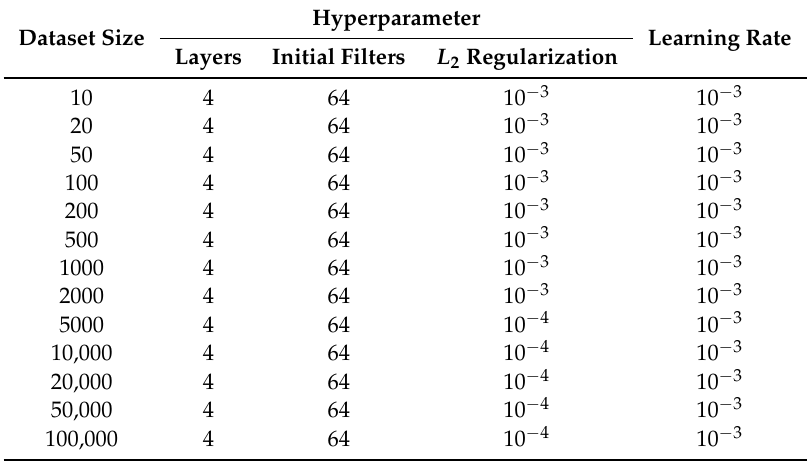
Table A4. Hyperparameters for U-Net yielding the highest validation accuracy across dataset sizes. Dataset